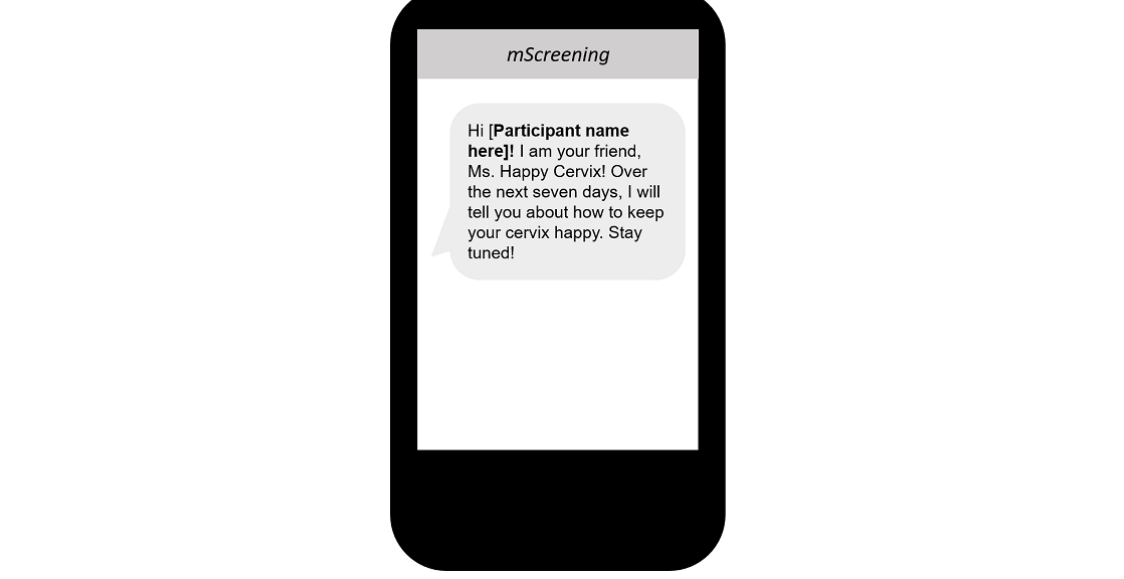
Subtheme 2.3: Interactive